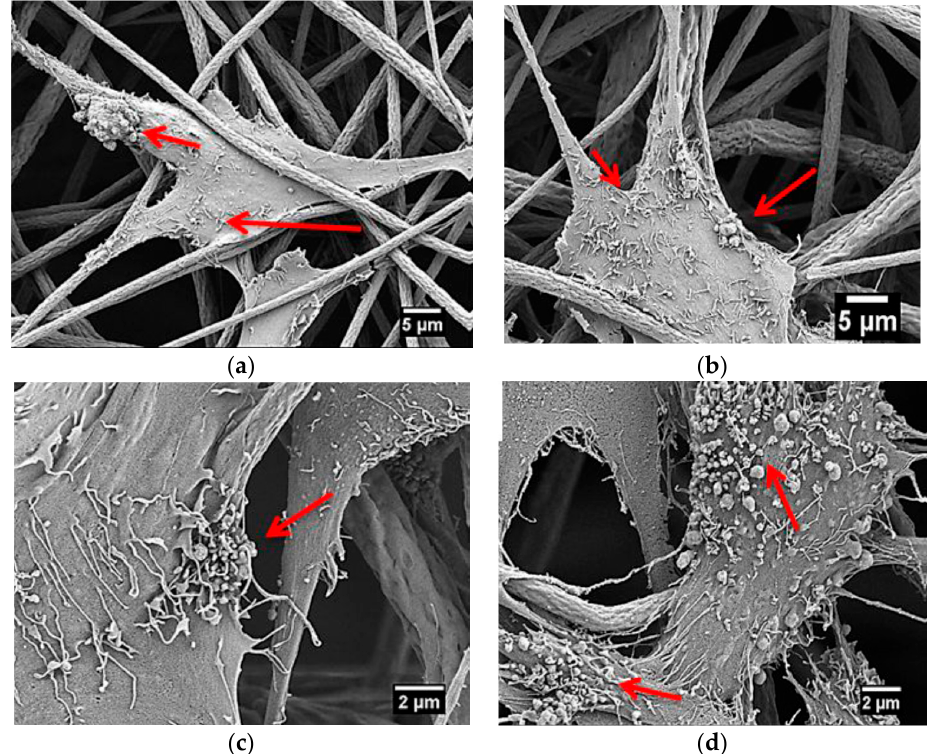
Figure 25. SEM images showing the formation of collagen fibrils on MG63 osteoblasts cultured on electrospun ( a ) PVDF(+) and ( b ) PVDF( − ) scaffolds for three days. Accumulation of collagen fibrils and calcium phosphate nodules on MG63 osteoblasts cultured on ( c ) PVDF(+) and ( d ) PVDF( − ) scaffolds for seven days. Red arrows indicate collagen fibrils present on cell surfaces. Reproduced with permission from [10], Copyright American Chemical Society, 2019.